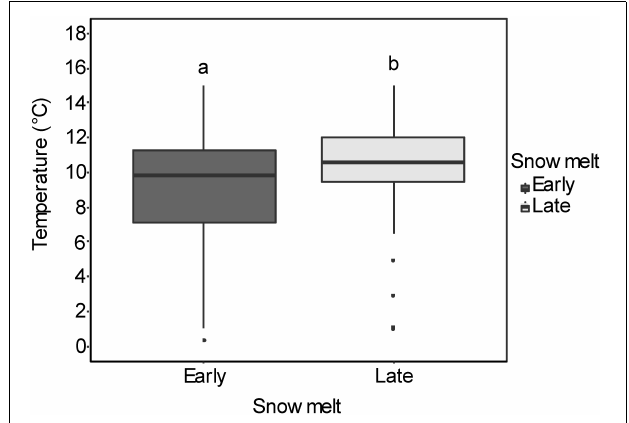
FIGURE 3 | Box-whisker plots for soil temperatures in early and late snowmelt areas (number of sites = 4) for 6 weeks from melt-out date in 2016. The boxes comprise the 25th and 75th percentile with the upper and lower whiskers extending from the hinge to the upper and lower 1.5 inter-quartile ranges, respectively. The different letters indicate significant differences ( P < 0.05) between early and late snowmelt areas. Detailed results of linear mixed effect models are given in Supplementary Table S4